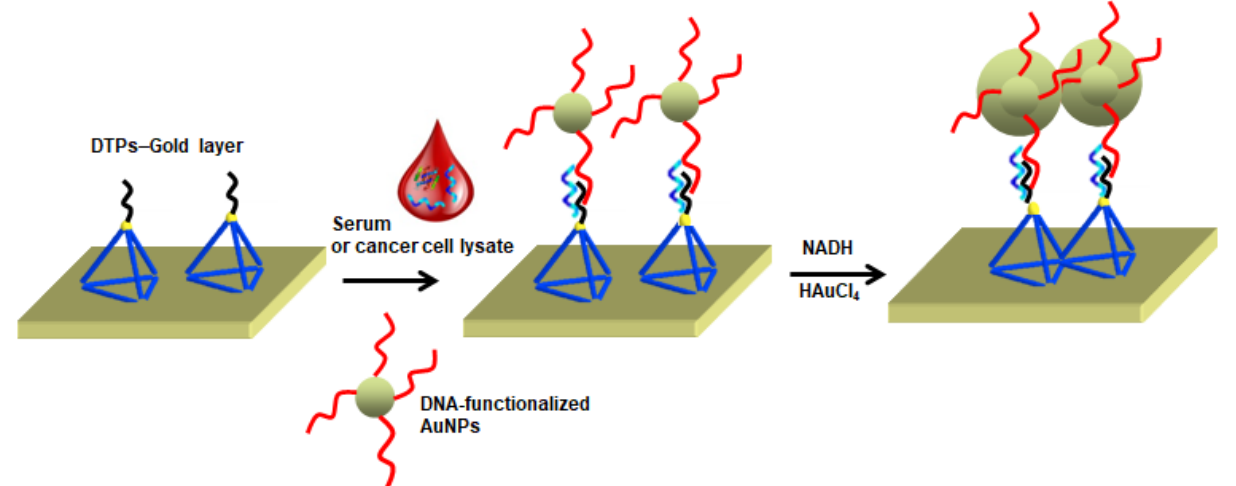
Figure 4. A pictorial illustration of the low-fouling SPR biosensor to detect miRNA in serum or cancer cell lysate based on the DNA tetrahedron probes (DTPs). Adapted with permission from Ref. [104]. Copyright (2018) American Chemical Society.